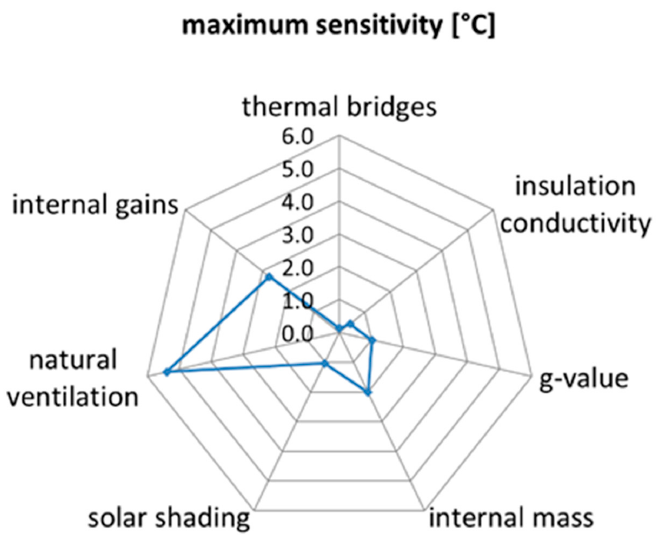
Figure 4. Sensitivity analysis—PoliTO-EnergyPlus (3rd week October 2017).